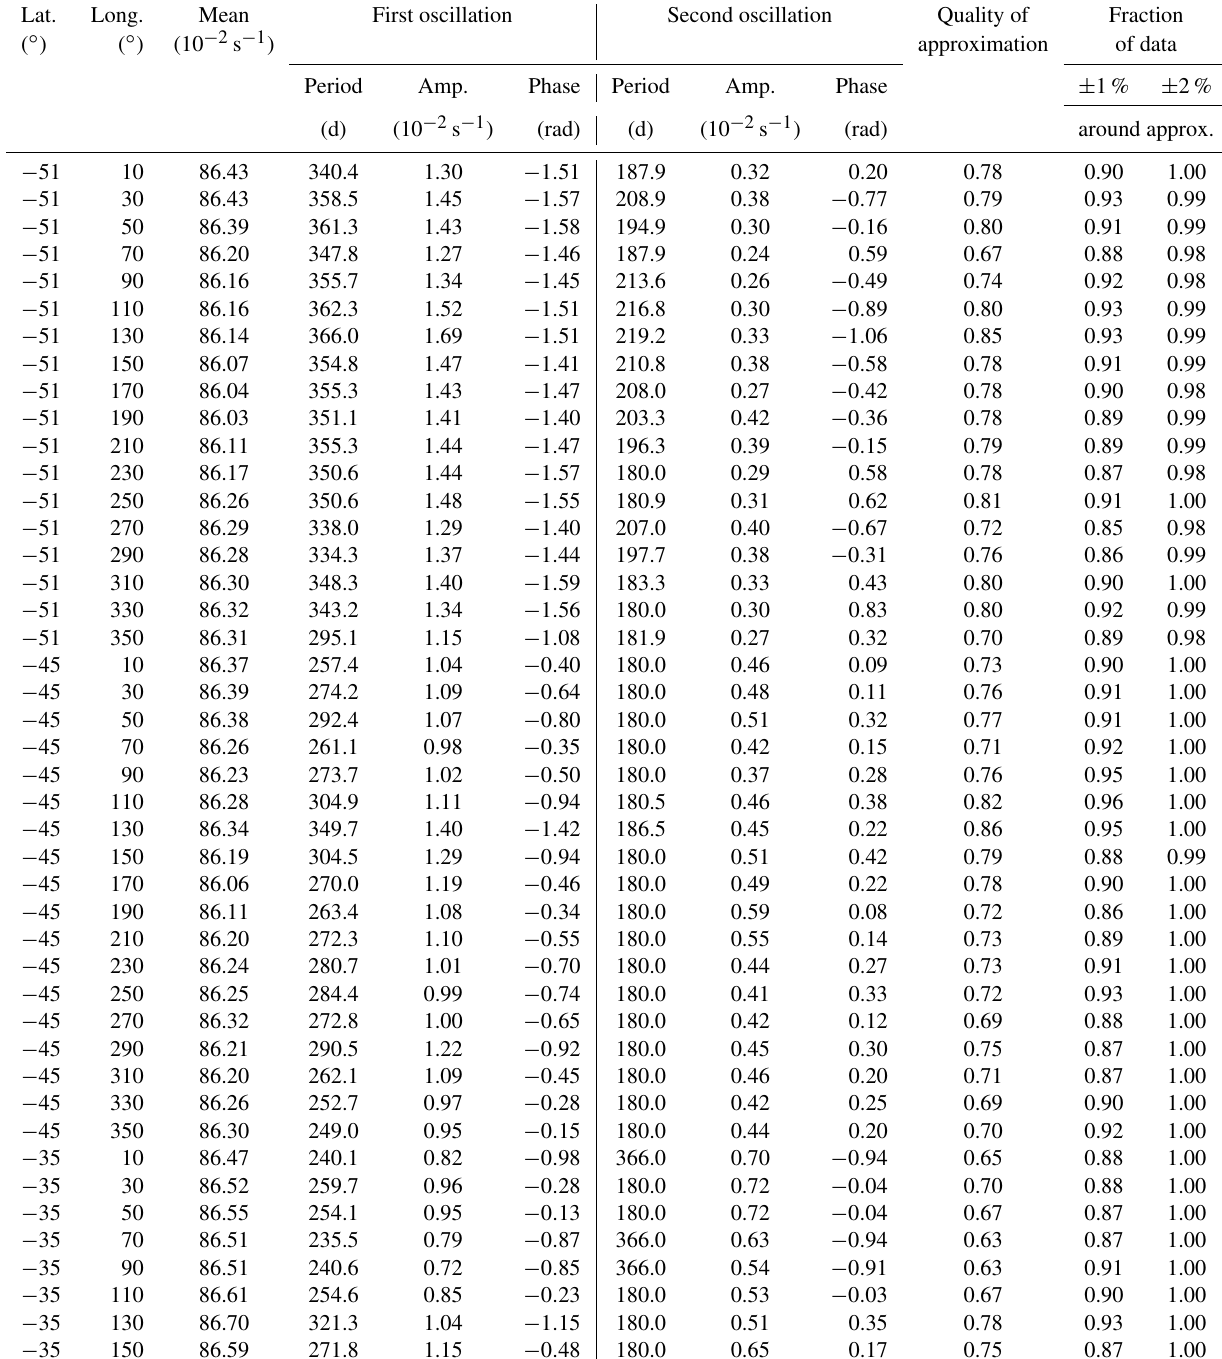
Table A1. Same as Table 1 but for the OH ∗ -layer height. Please note that OH ∗ -layer height is less variable during the year, and therefore the fraction of data around the approximation is provided for intervals of ± 1% and ± 2%.